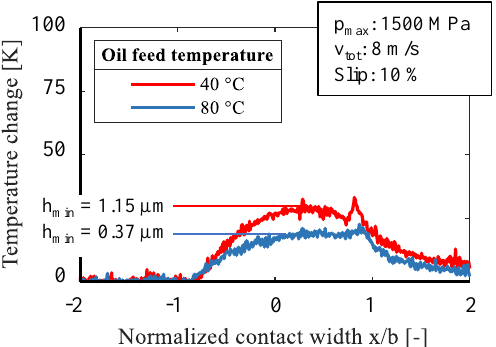
Figure 10. Influence of oil feed temperature on temperature change at 10% slip.